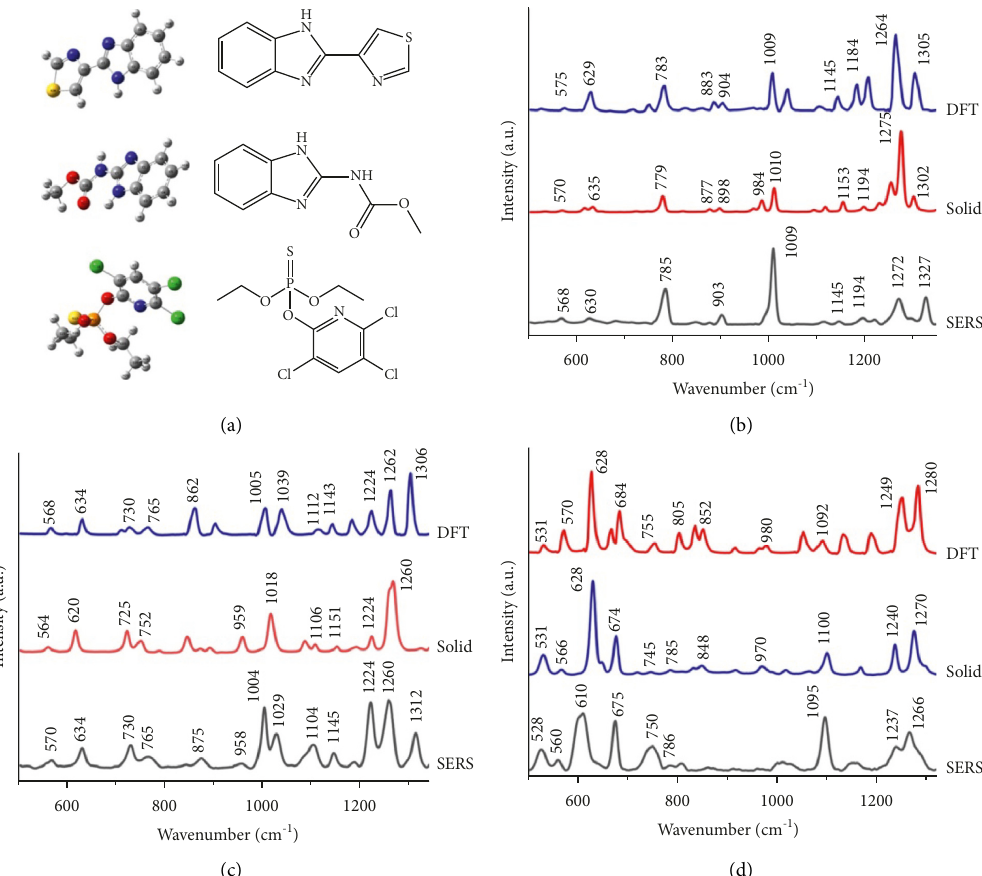
Figure 2: (a) the simulated molecular structure. Raman spectra of (b) thiabendazole, (c) carbendazim, and (d) chlorpyrifos. The blue line represents the density functional theory (DFT)-calculated Raman spectra of the pesticide. The red line represents Raman spectra of the pesticide solid. The black line represented SERS spectra of the pesticide